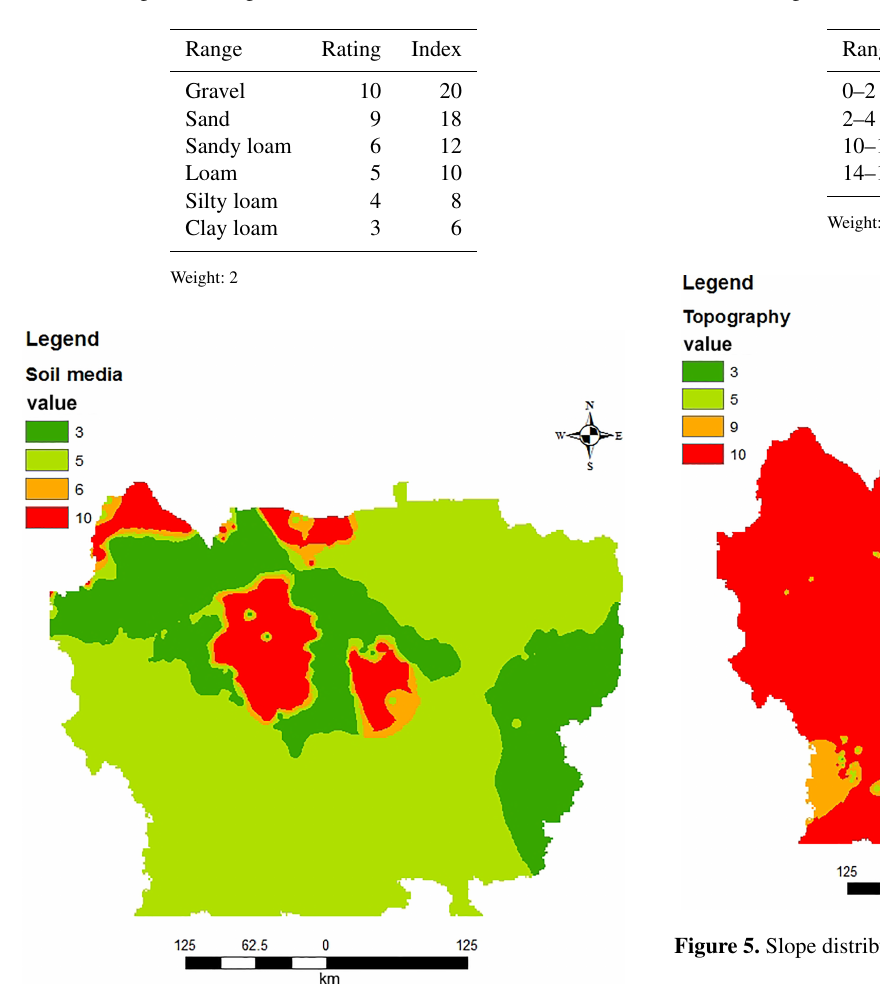
Table 5. Range and rating for topography (slope).